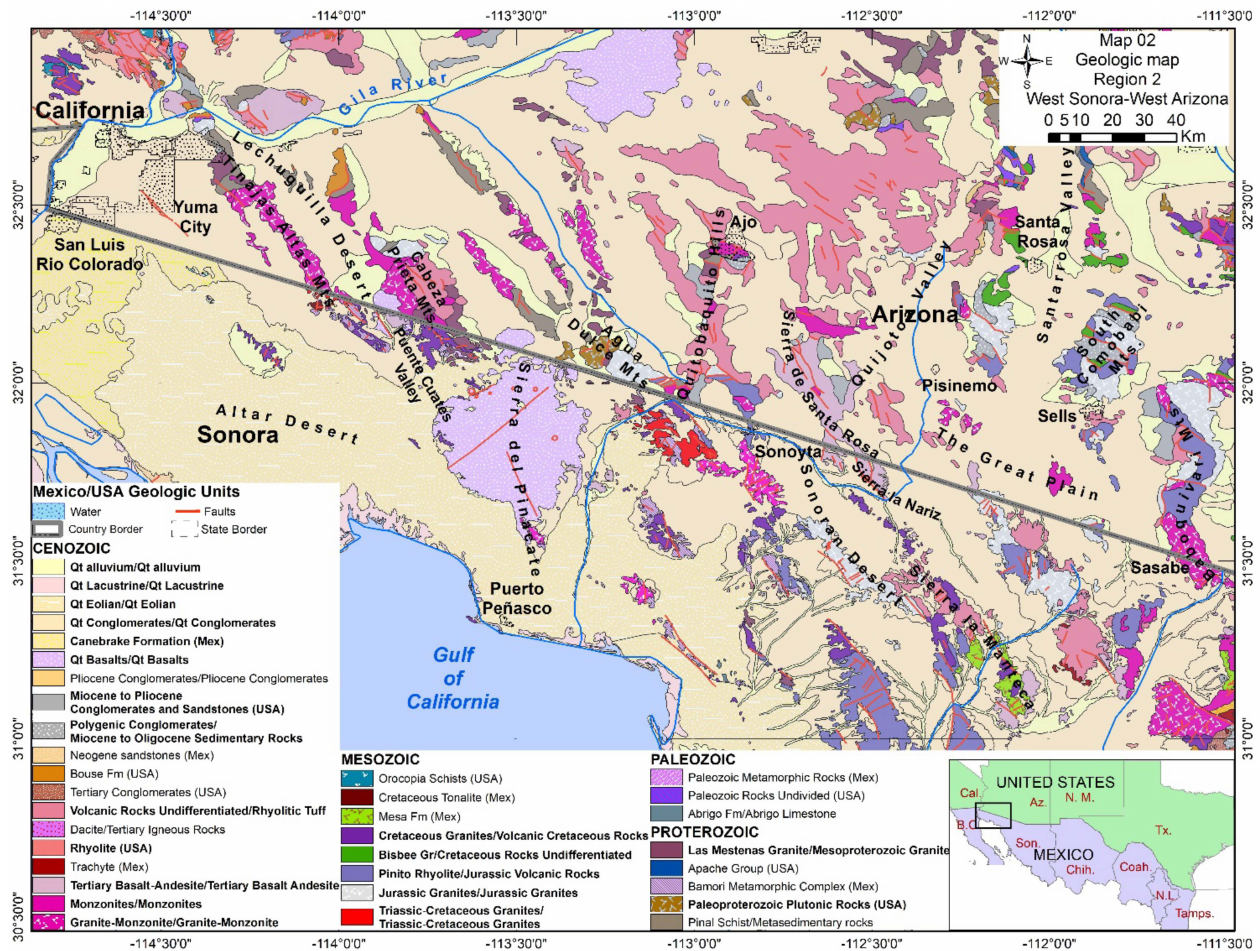
Figure 2. Geologic map, West Sonora—West